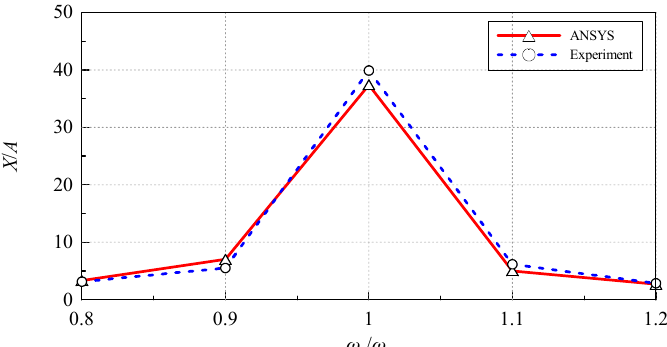
Figure 7. The comparison of ANSYS simulated results and the experimental measurements; X / A: the dimensionless displacement of OWT; ω x / ω s = 1: excitation frequency ( ω x ) is equal to the natural frequency of OWT ( ω s ).